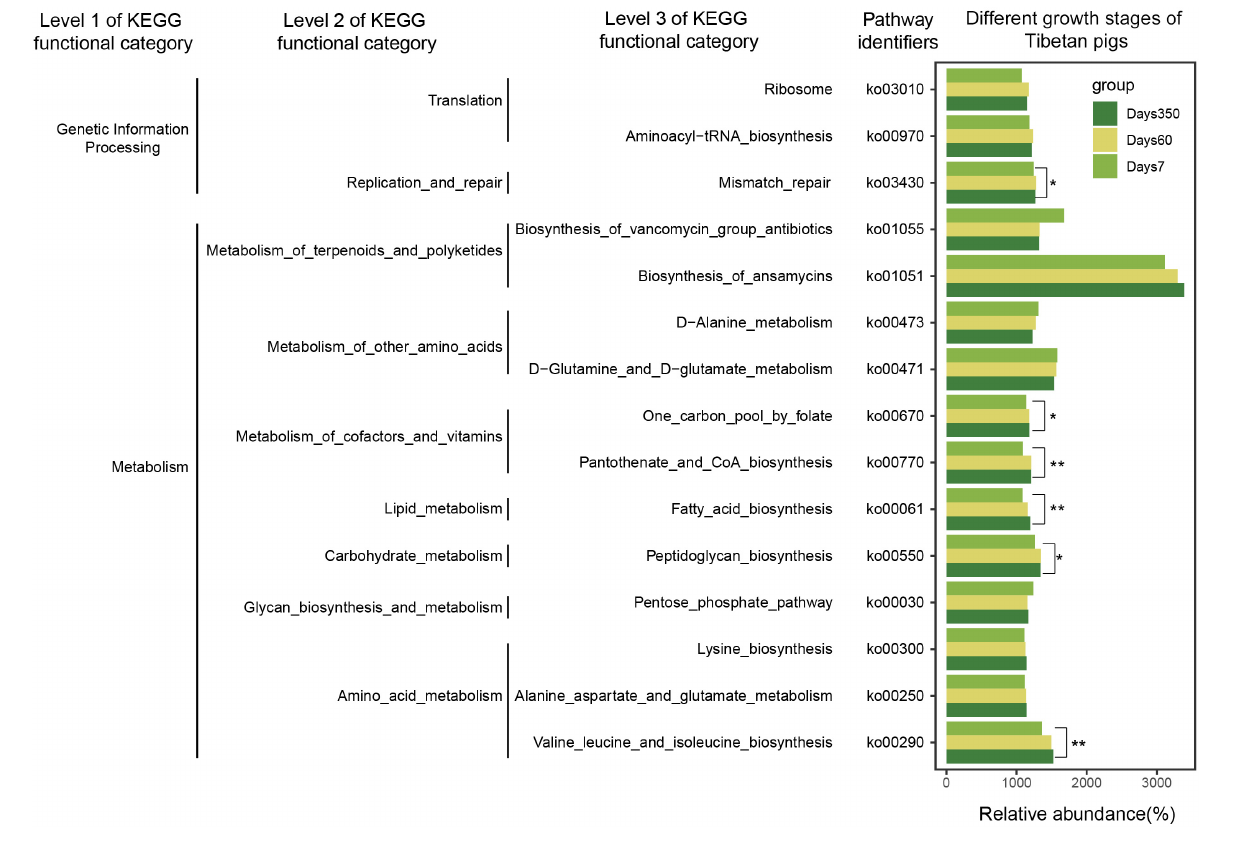
Frontiers in Microbiology |